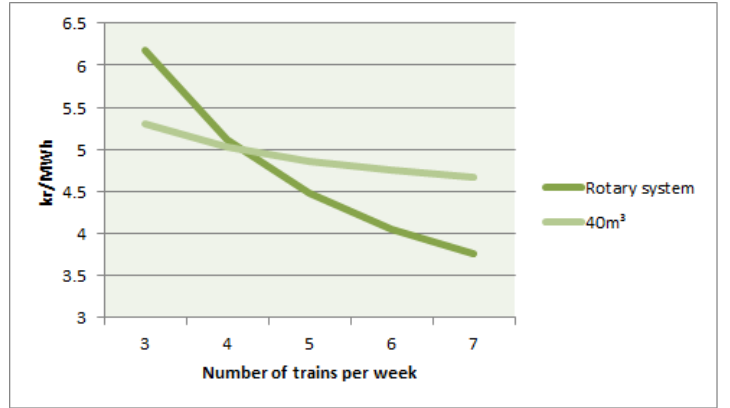
Figure 11. Unloading costs for rotary system and 40m 3 using hooklift trucks.